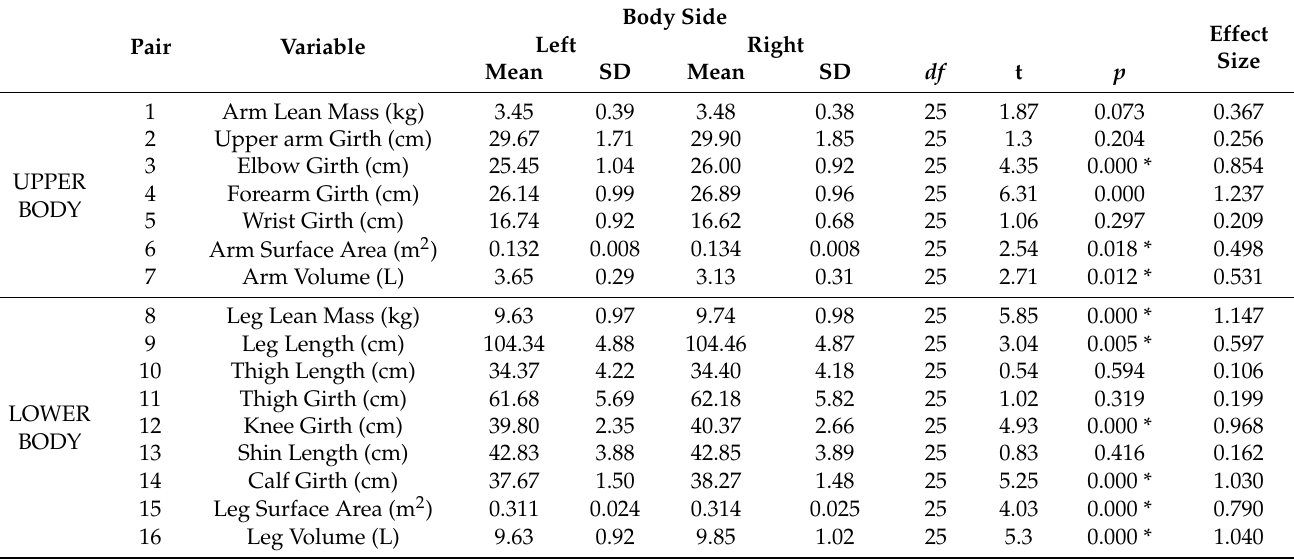
Table 2. Mean ( ± SD) values for left and right morphological variables with a paired t -test between paired variables of the LPG of road cyclists.